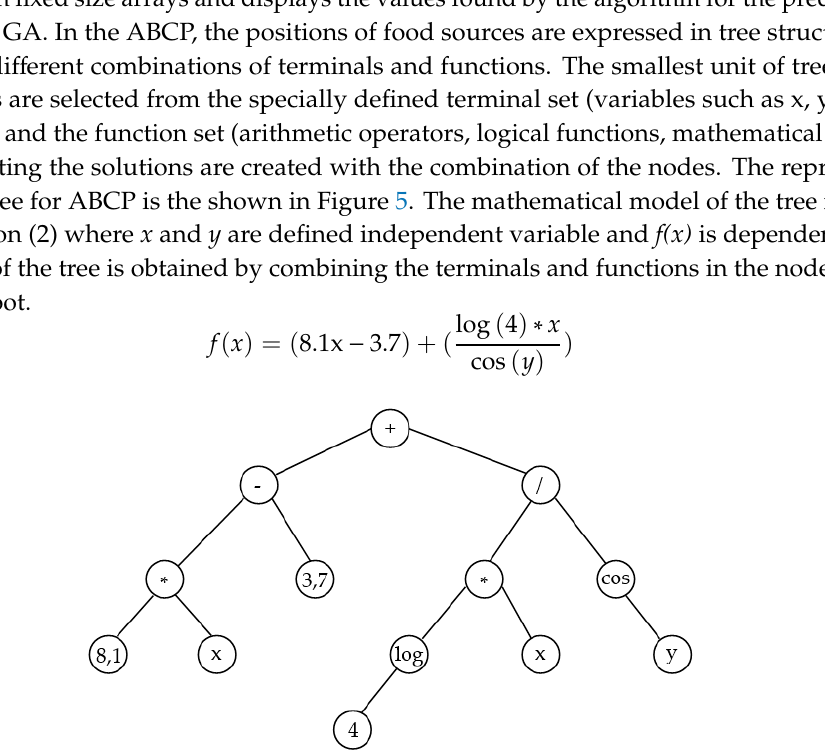
Figure 5. Representation of solutions in ABCP by tree structure.